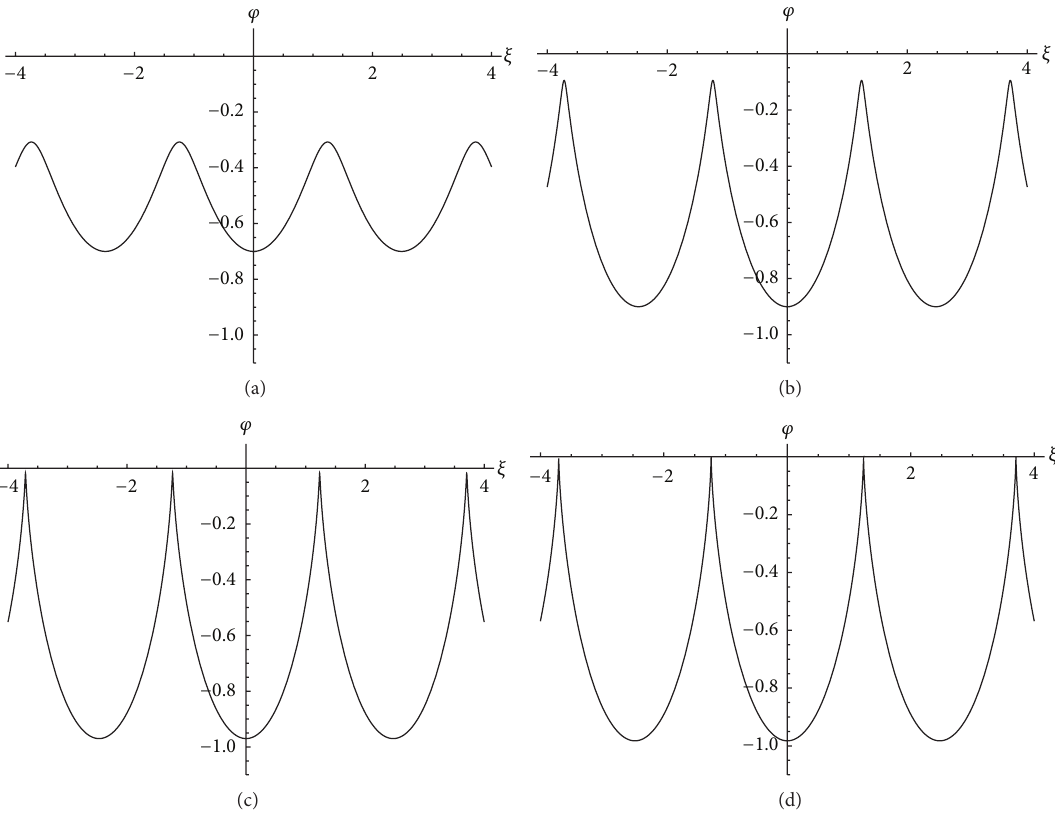
Figure 5: The simulations of periodic integral curves of (8) for Case 5, where the initial values (𝜑(0),𝜑 󸀠 (0)) = (−0.7, 0),(−0.9, 0),(−0.98, 0) , (−0.9854465, 0)